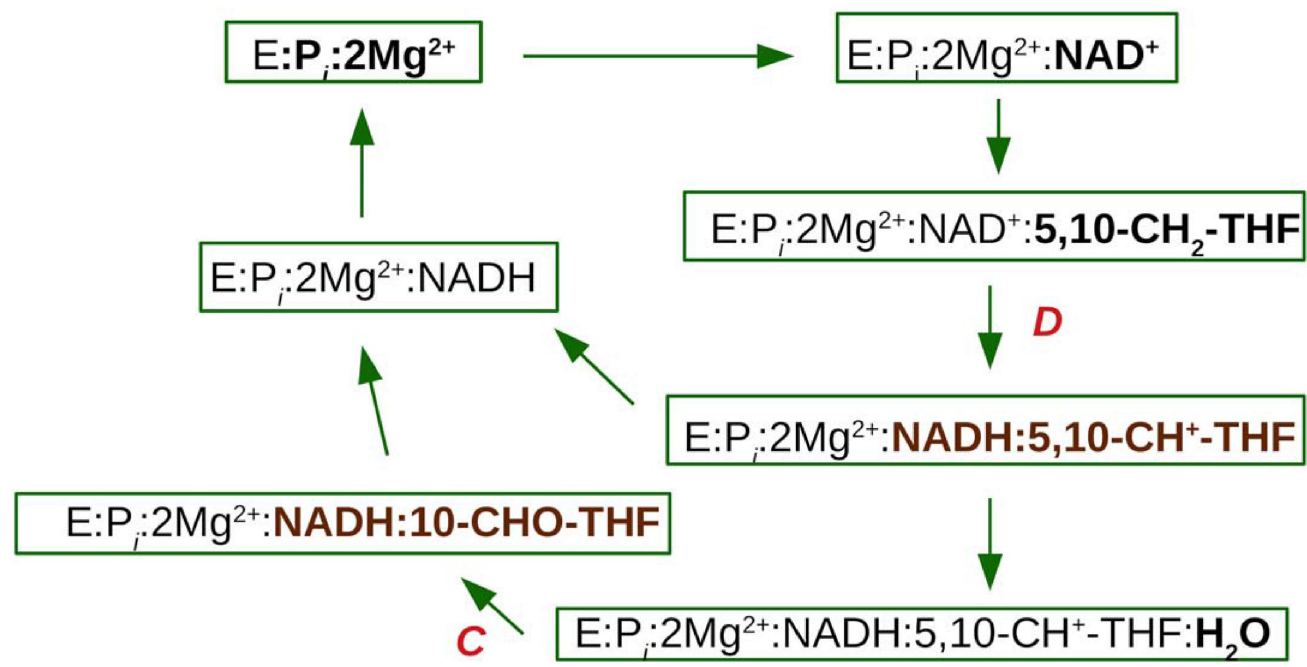
Fig 4. Catalytic cycle for the dehydrogenase ( D ) and cyclohydrolase ( C ) activities.